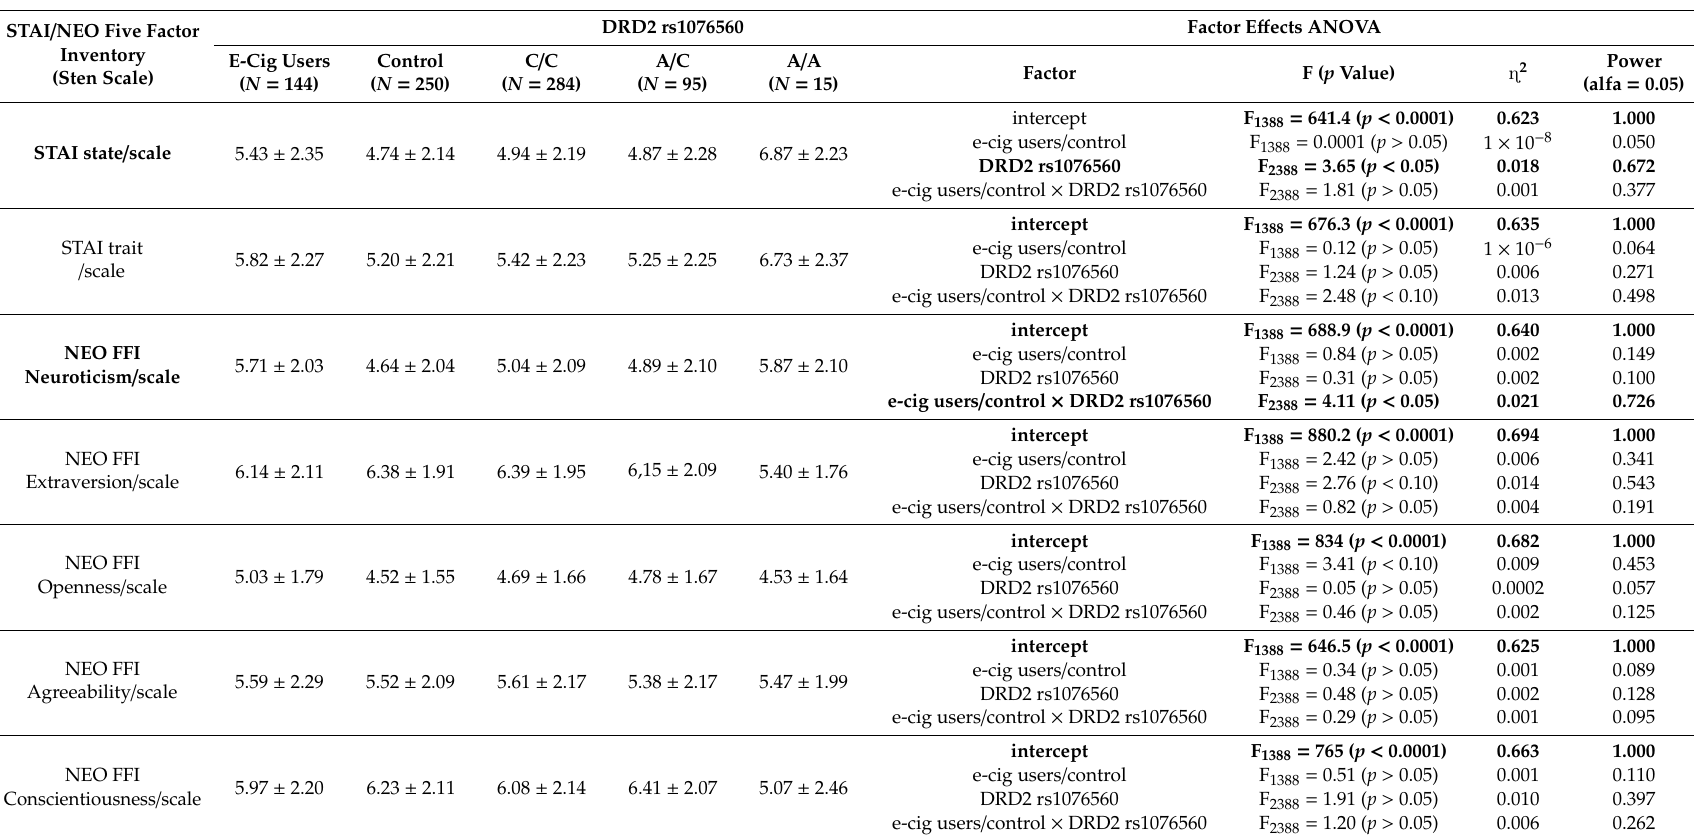
Table 3. Di ff erences in DRD2 rs1076560 and STAI / NEO Five Factor Inventory between control subjects and e-cigarette